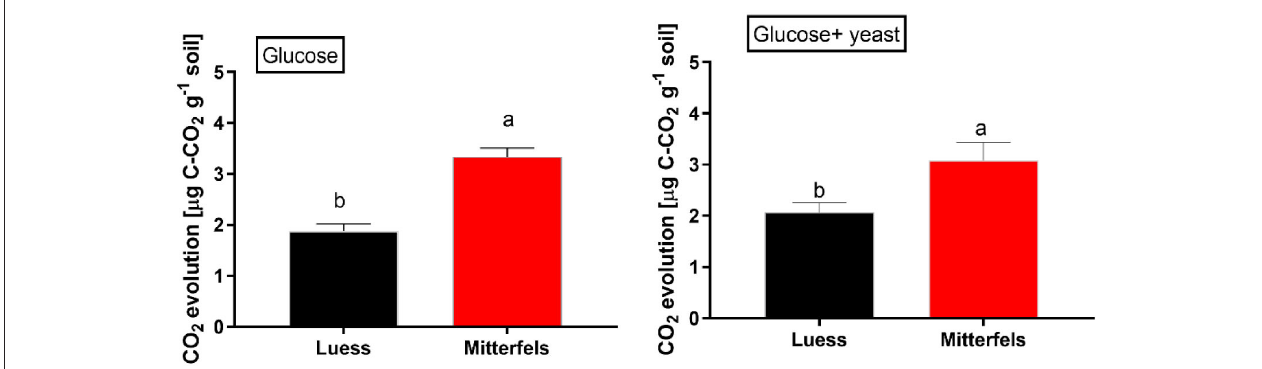
FIGURE 2 | Soil substrate-induced respiration (SIR) including standard error of mean (SEM) measured by CO 2 production in two forest soils planted with beech. Significant differences between the sites are denoted by lower case letters at a significance level of p < 0.05. Note, SIR-derived CO 2 is measured before exponential growth phase sets